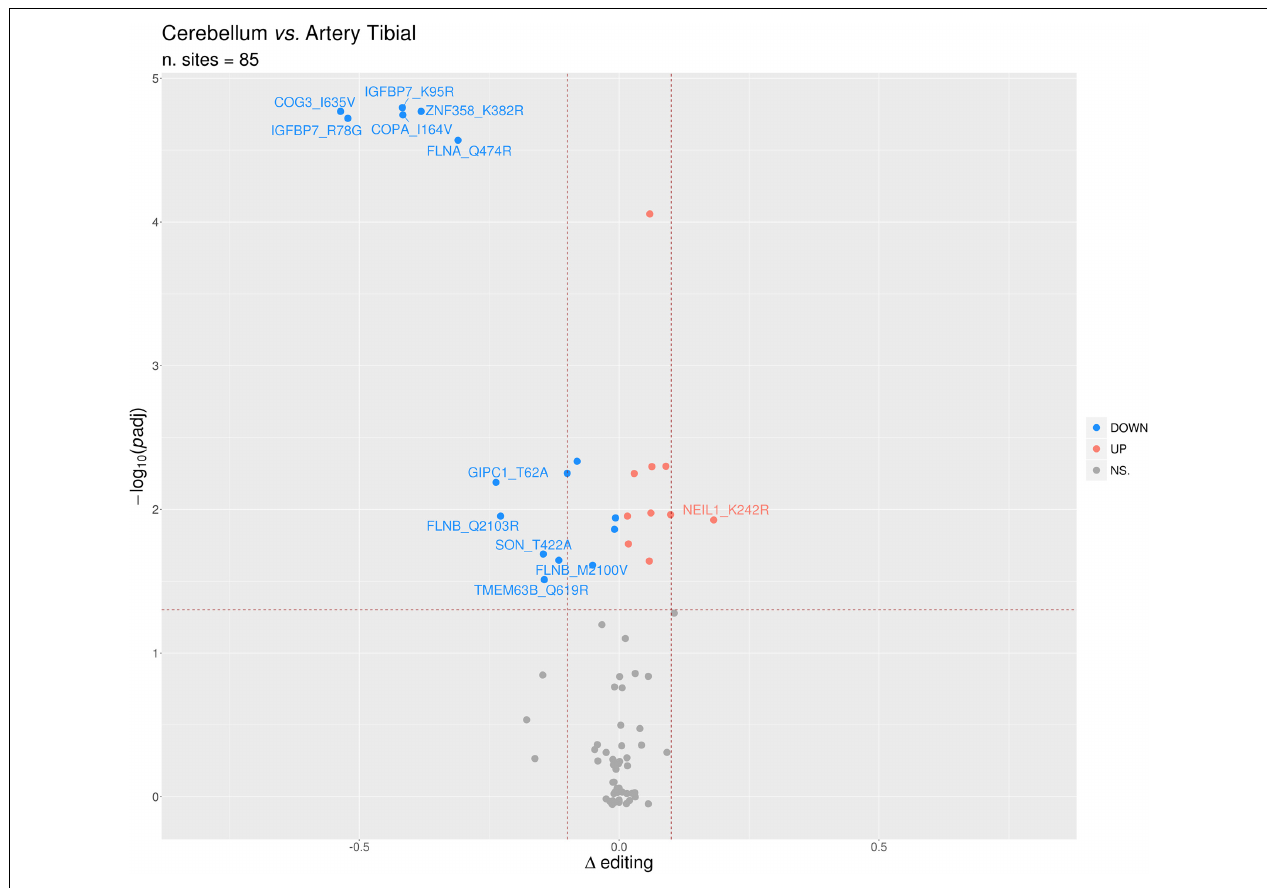
FIGURE 10 | Volcano plot reporting the differentially edited sites between cerebellum and tibial artery. The horizontal dotted line marks a multiple test-corrected level of significance (adjusted padj < 0.05, Mann–Whitney with Benjamini–Hochberg correction). The vertical dotted lines indicate a Delta editing of 0.1 and -0.1. Red, blue, and gray points indicate, respectively, over-edited (UP) sites, under-edited (DOWN) sites, and non-significative sites (NS.).